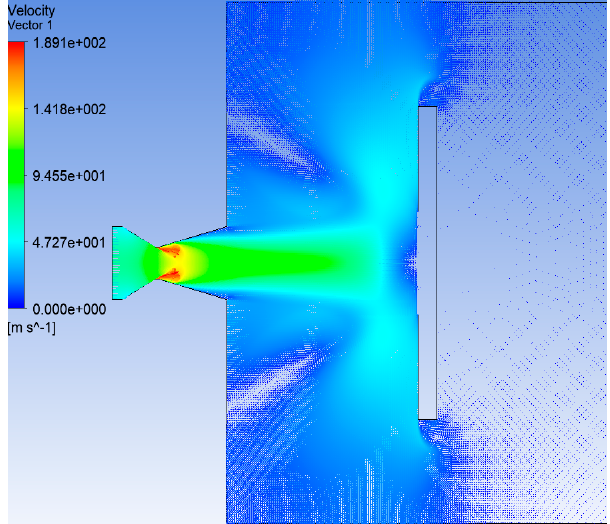
Figure 13. Distribution of heat flow velocity.